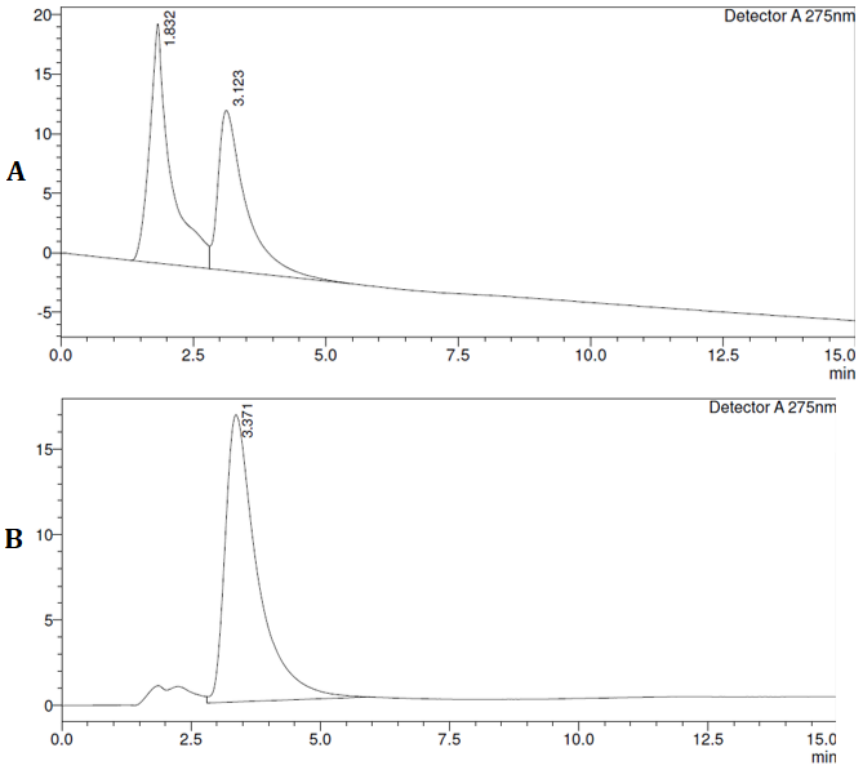
Figure 1. The images of TLC profile Ficus septica leaf extract. A: ekstract; B: tylophorine; 1: UV 254 nm; 2: UV 366 nm; 3: after spraying Dragendorff. The stationary phase: Silica gel 60 F254; Mobile phase: 2- propanol: glacial acetic acid: aquadest (5:1:1).